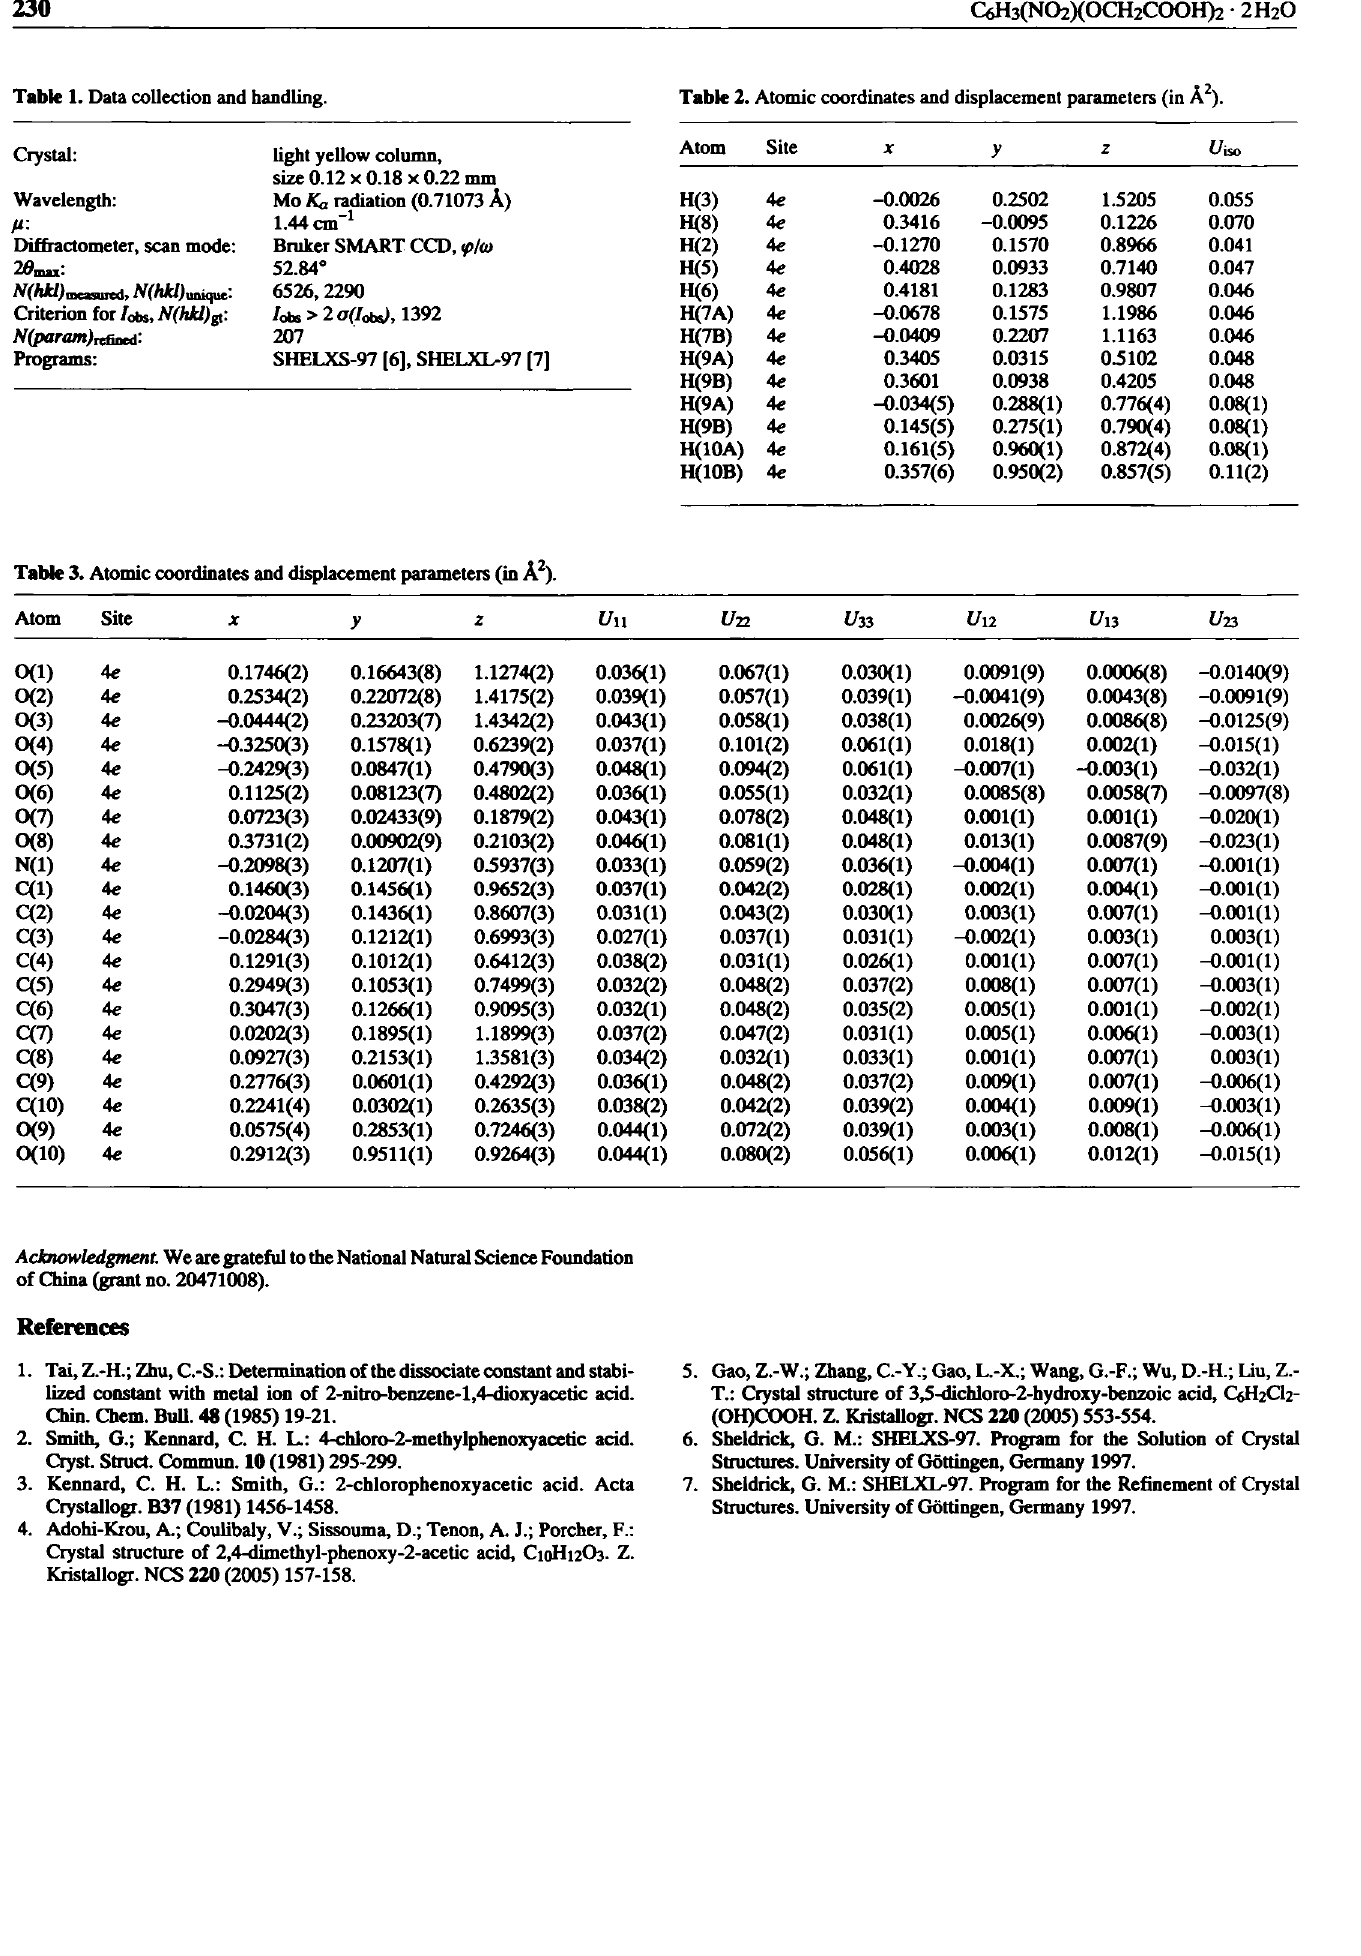
Table 3. Atomic coordinates and displacement parameters (in Ä 2